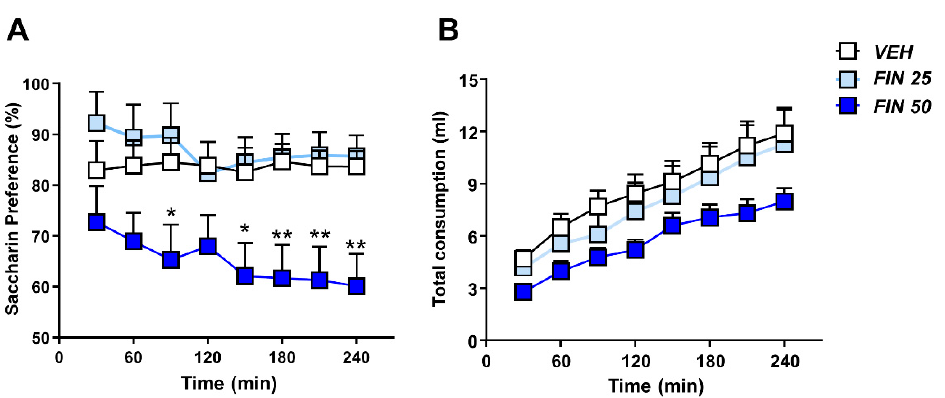
Figure 6. Finasteride reduced saccharin preference. The 50 mg / kg dose of FIN reduced saccharin preference in the saccharin preference test ( A ) without modifying total liquid consumption ( B ); n =